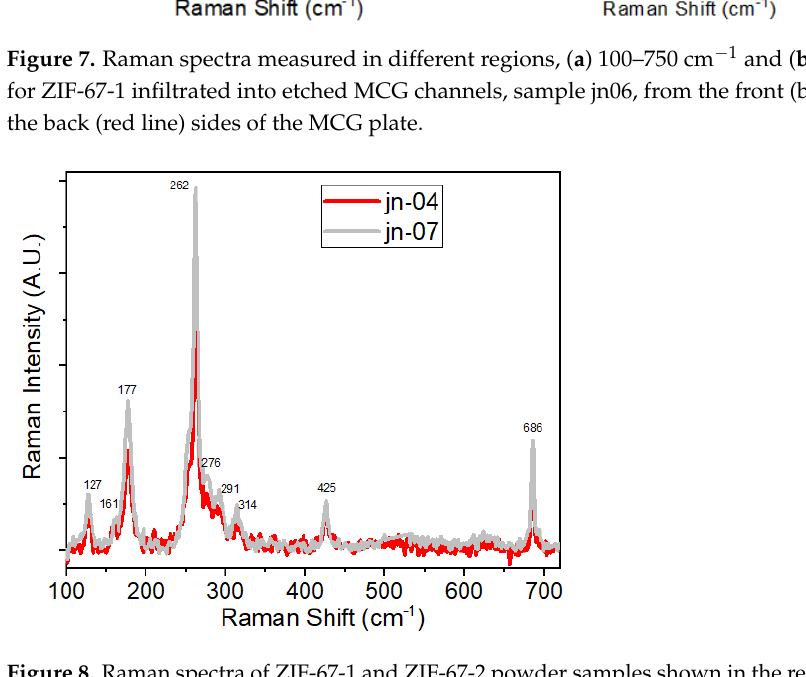
Figure 8. Raman spectra of ZIF ‐ 67 ‐ 1 and ZIF ‐ 67 ‐ 2 powder samples shown in the region 100–750 cm − 1 to demonstrate the low ‐ frequency peaks at 121, 161, and 177 cm − 1 .